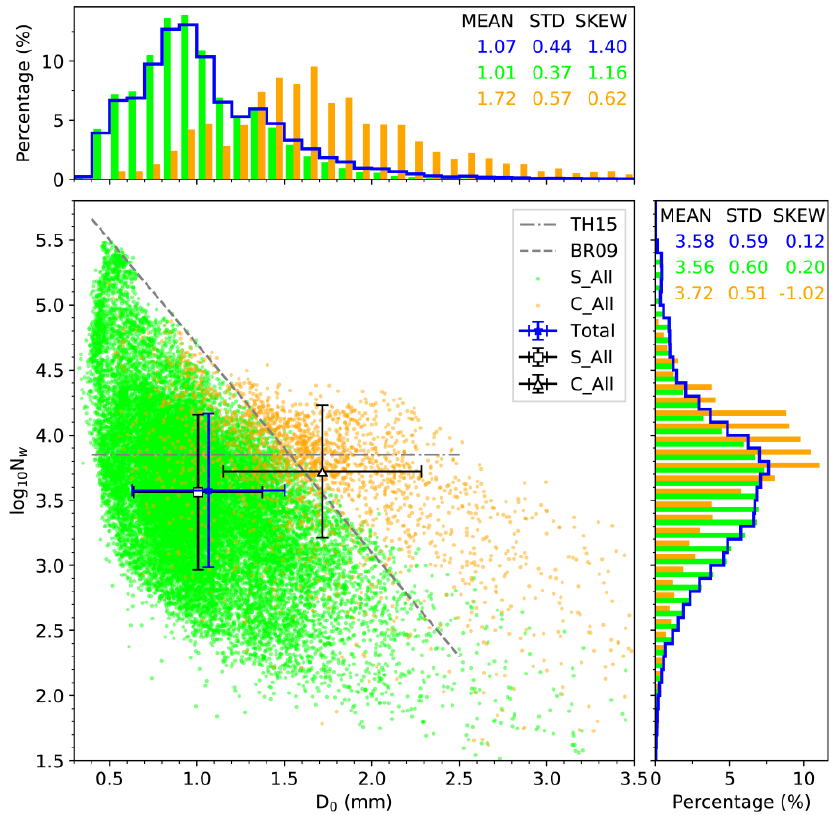
Figure S1. As in Figure 4, but for the TE01 classification scheme. Figure A1. As in Figure 4, but for the TE01 classification